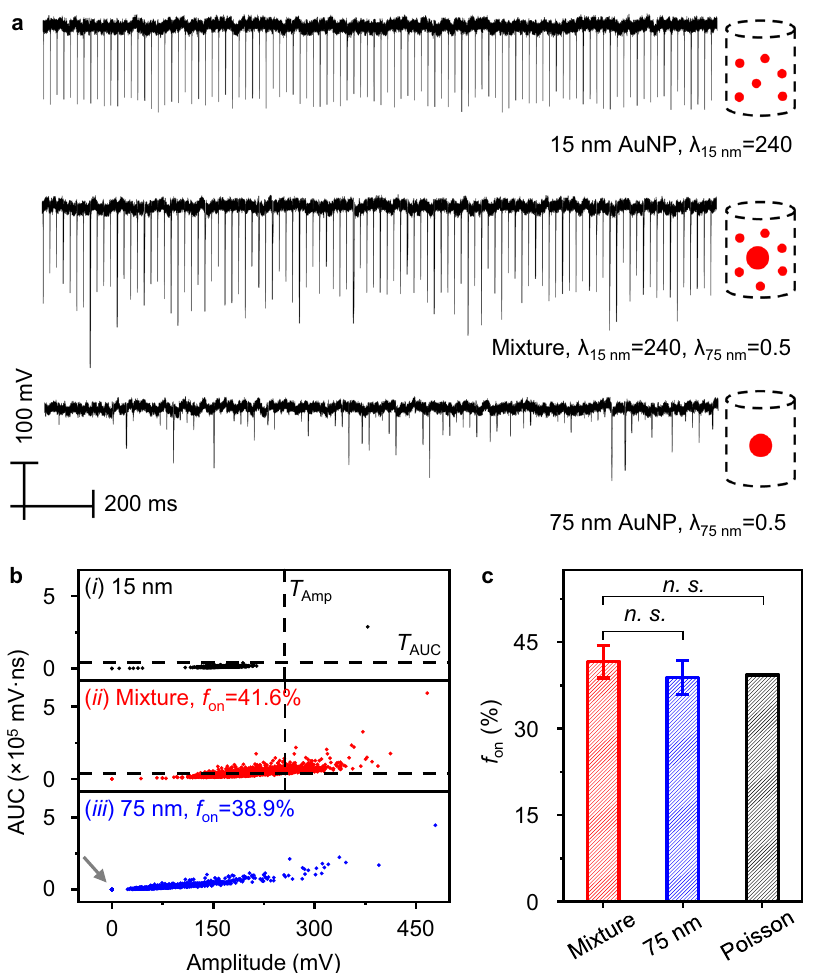
Fig. 3 Identi fi cation of large AuNP in a heterogenous AuNP solution by DIAMOND. a Representative PNB signals traces (100 pulses) for 15 and 75 nm AuNPs and their mixture. Schematics represent the sample information. b Bivariate plots of amplitude and AUC extracted from 3000 pulses for the three samples in ( a ). Cases (i – iii) refer to the suspensions of 15 nm, mixture, and 75 nm AuNPs, respectively. The dashed lines in cases (i) and (ii) indicate the same thresholds of amplitude ( T Amp ) and AUC ( T AUC ). The gray arrow in case (iii) highlights scatters at 0. c Bar plot of experimental frequencies ( f on ) as determined in ( b ) for cases (ii) and (iii) and theoretical probability predicted by Poisson statistics. n.s. stands for no signi fi cant difference ( p -value > 0.05). The error bars for experimental f on indicate the standard deviations of three independent